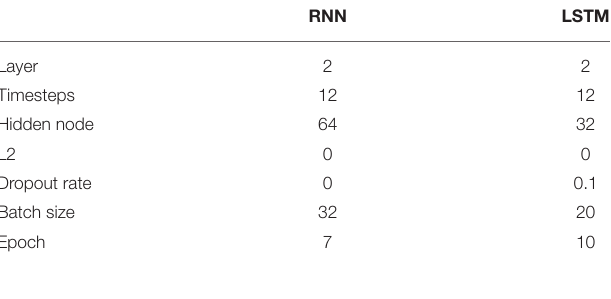
TABLE 3 | Exploration results of hyperparameters.